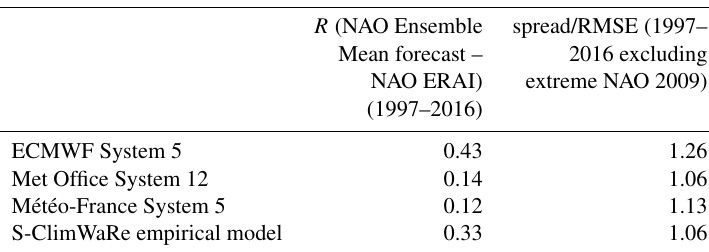
Table 1. Table showing correlation coefficient between winter NAO index (averaged over December–February) computed from ensemble mean forecasts and from ERA Interim re-analysis for a selection of models initialized in October covering the period 1997–2016. Ratio of NAO index ensemble spread and RMSE of the ensemble mean of NAO index is also shown for the period 1997–2016, excluding the extreme NAO 2009/2010